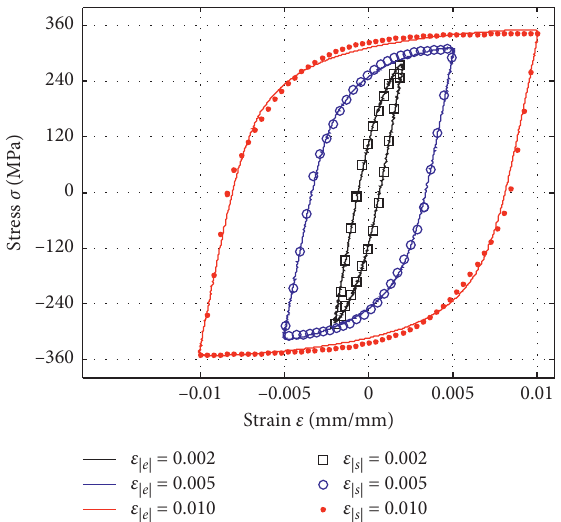
Figure 3: Experimental and simulation σ − ε curves under uniaxial loading at different strain amplitudes for Q235 steel. Note: ε is the value of strain amplitude when did, and that taking e denotes experiment and taking s denotes simulation.